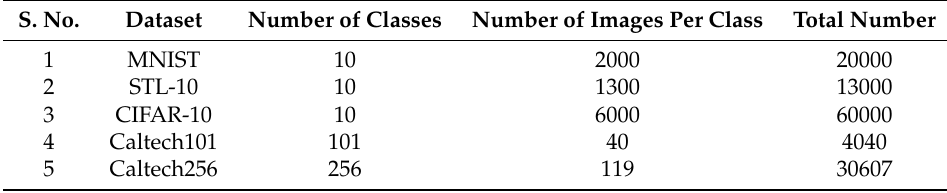
Table 3. Standard Datasets.